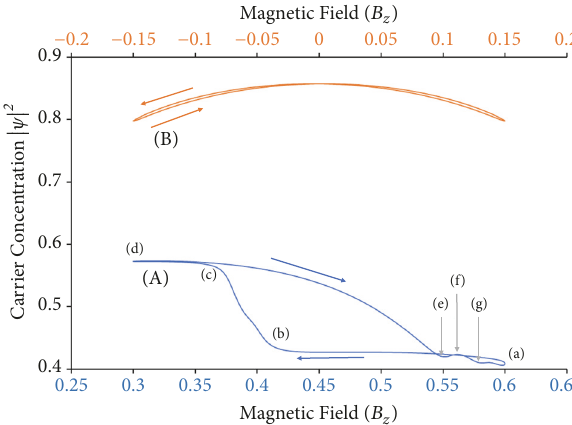
Figure 1: Variation of carrier concentration with magnetic field for cubic sample of side 20𝜉 each, with parameters 𝜅 = 4 and 𝜎 = 1 under magnetic fields (A) 𝐵 𝑧 = 0.45𝜅 + 0.15𝜅 cos 𝜃 and (B) 𝐵 𝑧 = 0.15𝜅 cos 𝜃